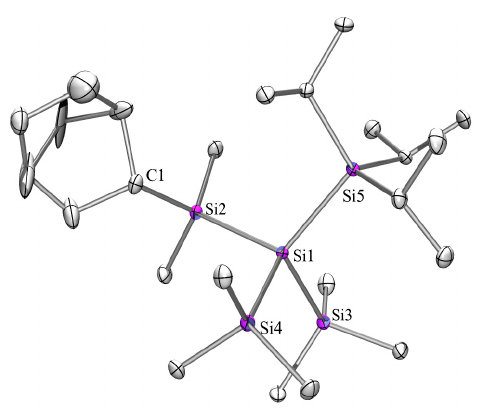
Figure 22. Crystal structure of 24 . Thermal ellipsoids are represented at the 30% level and hydrogen atoms have been omitted for clarity (bond lengths in Å, angles in deg). C(1)-C(2) 1.543(5), C(1)-Si(2) 1.914(3), Si(1)-Si(4) 2.3649(11), Si(4)-Si(1)-Si(3) 104.76(4), Si(4)-Si(1)-Si(2) 106.26(4), Si(3)-Si(1)-Si(2) 105.44(4).